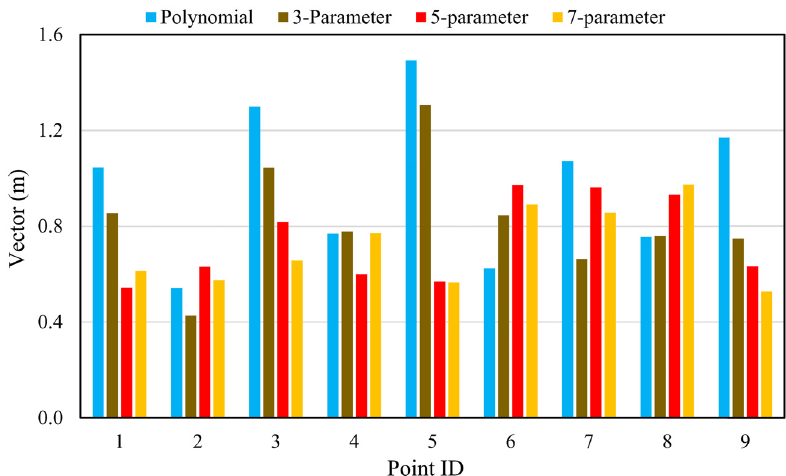
Figure 13: Interface to transform between geodetic and Cartesian